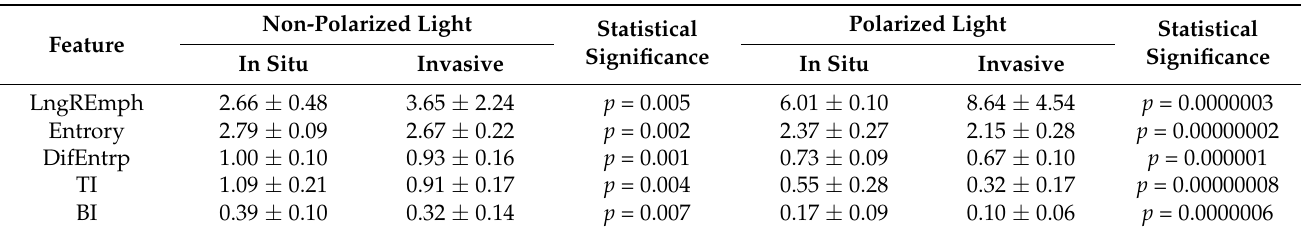
Table 2. Results of the five investigated texture features of in situ and invasive melanoma images taken under non-polarized and polarized